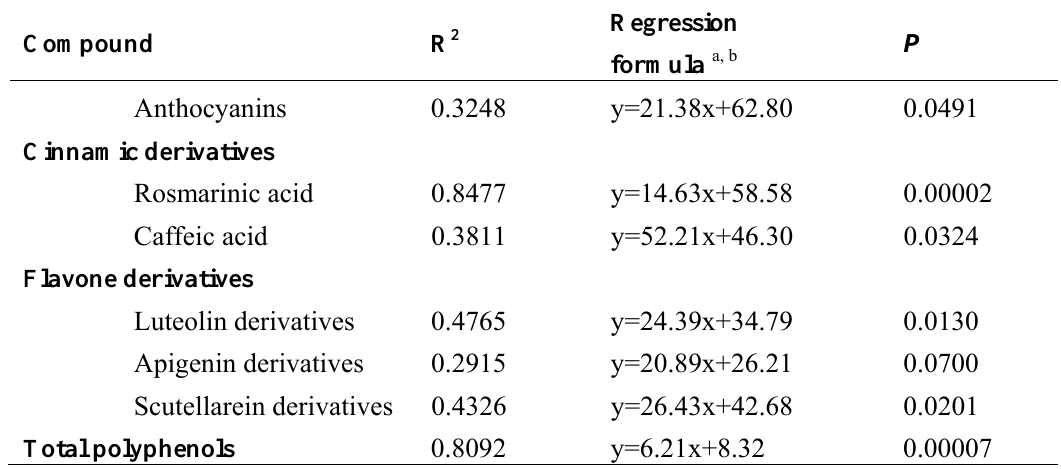
Table 2. Correlations between Antioxidant Activity (TEAC) and the main Polyphenolic compounds identified in Perilla frutescens leaf water